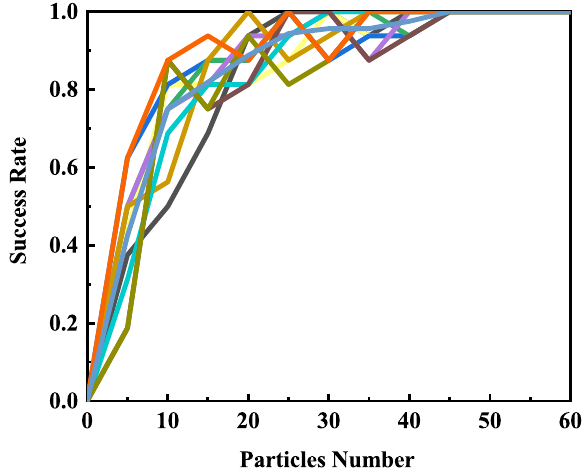
Figure 6. The relationship between success rate and particle number.